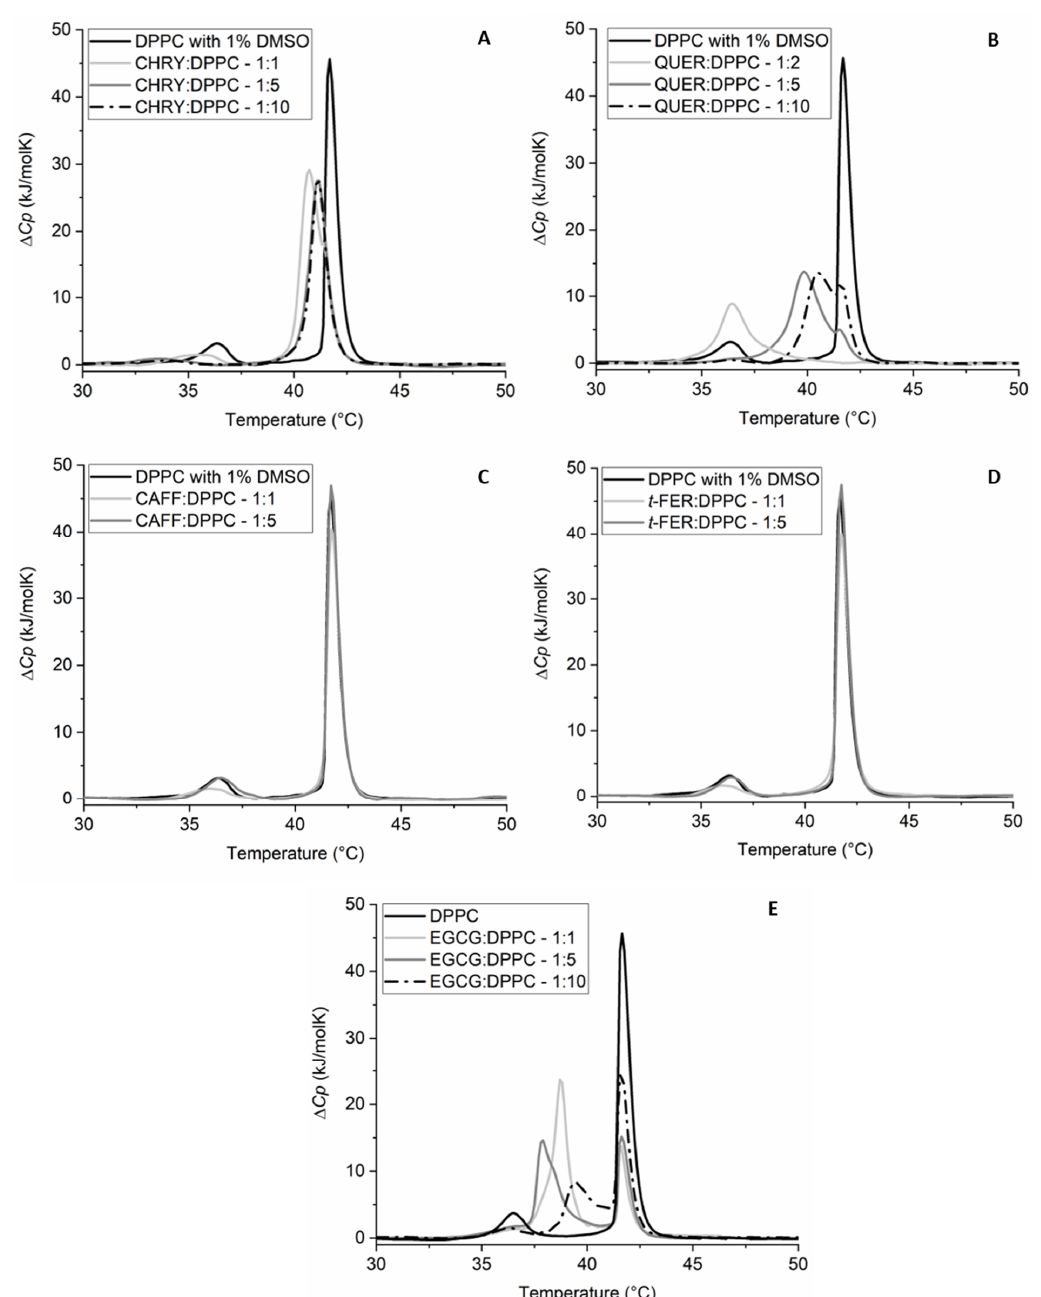
Figure 4. DSC thermograms of 1,2-dipalmitoyl- sn -glycero-3-phosphatidylcholine (DPPC) liposomes in 20 mM HEPES (pH = 7.0) buffer with or without the addition of 1% dimethyl sulfoxide (DMSO) (negative controls) and in the presence of chrysin (CHRY) ( A ), quercetin (QUER) ( B ), caffeic acid (CAFF) ( C ), and trans -ferulic acid ( t -FER) ( D ) (all in 1% DMSO and HEPES) or (-)-epigallocatechin-3-gallate (EGCG) ( E ) (in HEPES) at different n compound : n DPPC molar ratios. Δ C p is the change in heat capacity.